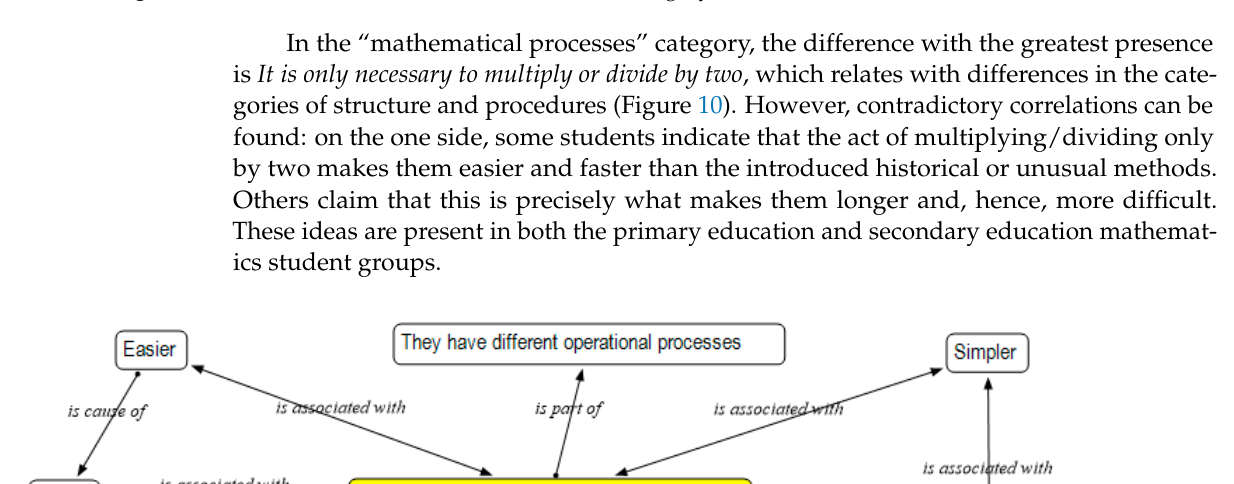
Figure 9. Relations of the slower difference with the category of “structure of the method”.